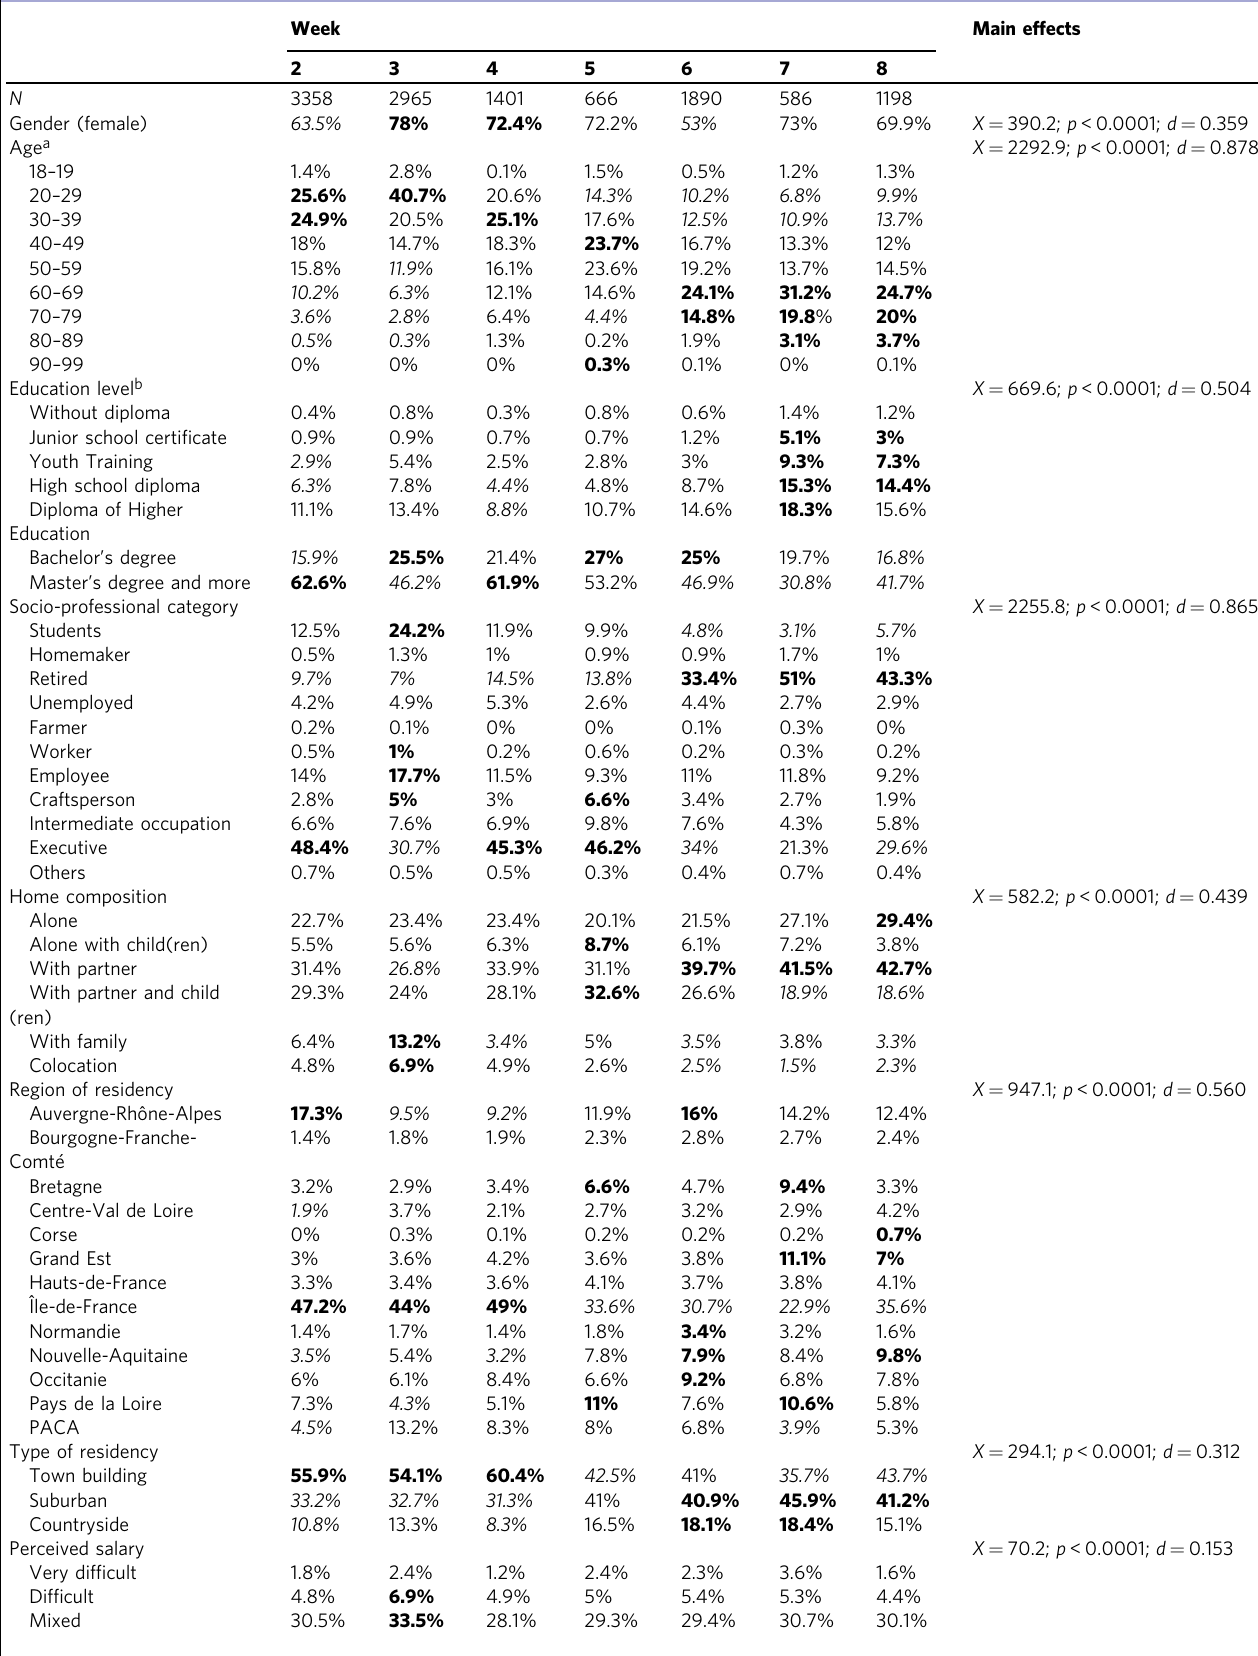
Table 1 Participants description for each lockdown